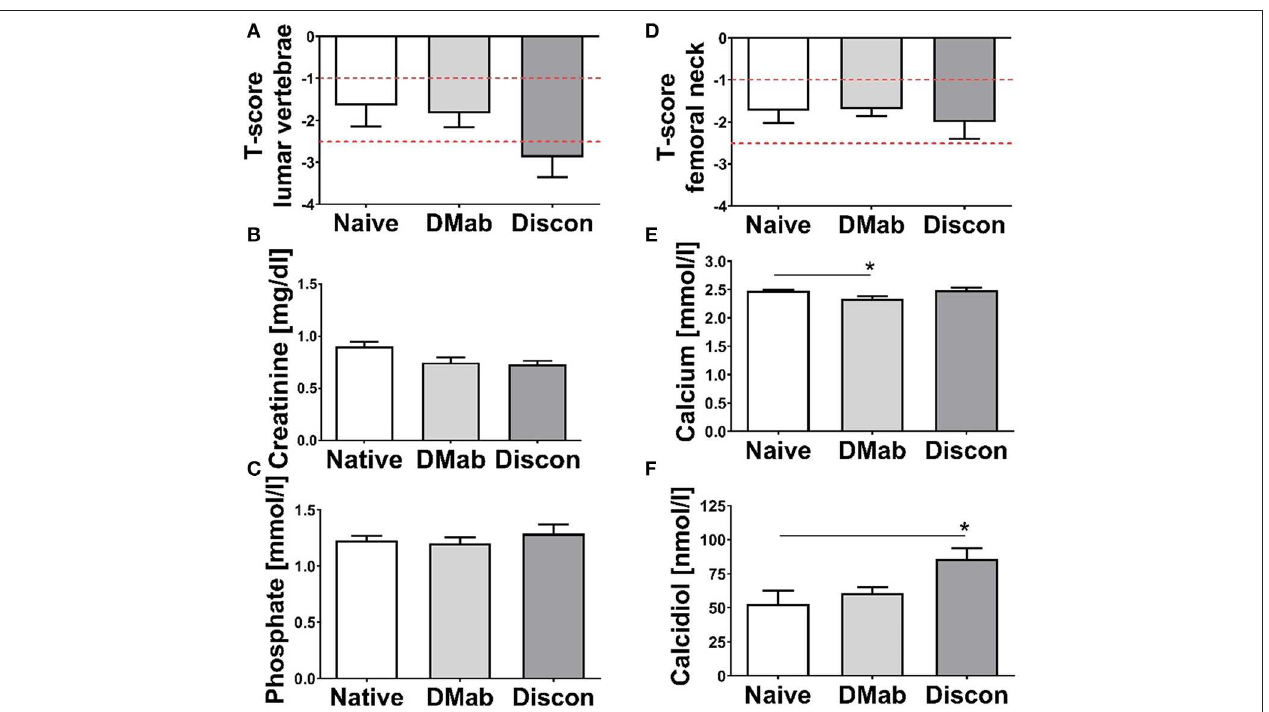
FIGURE 2 | Osteodensitometry and laboratory data. T-scores were measured at the time of biopsy collection using dual-energy X-ray absorptiometry (DXA) in (A) the lumbar vertebrae (L1–L4) and in (B) the left femoral neck. Cutoff thresholds for osteopenia ( − 1 > T-score > − 2.5) and osteoporosis (T-score < − 2.5) are marked with dashed red lines. Quantification of serum parameters (C) creatinine, (D) calcium, (E) phosphate, and (F) 25-OH-Vitamin-D3 (calcidiol) taken at the time of biopsy. Levels for creatinine, calcium, and inorganic phosphate were in the physiological range. Low calcidiol levels were detected in both the treatment-naive and the denosumab group. Data presented as mean and SEM. Statistical analyses were performed using one-way ANOVA and Tukey post hoc test with * p <